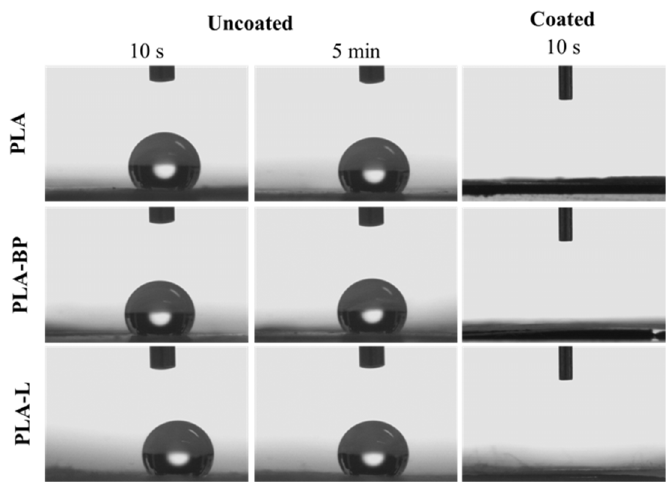
Figure 5. Images of a water drop on uncoated and coated PLA, PLA-BP and PLA-L fibres after 10 s and 5 min from drop dispensation.